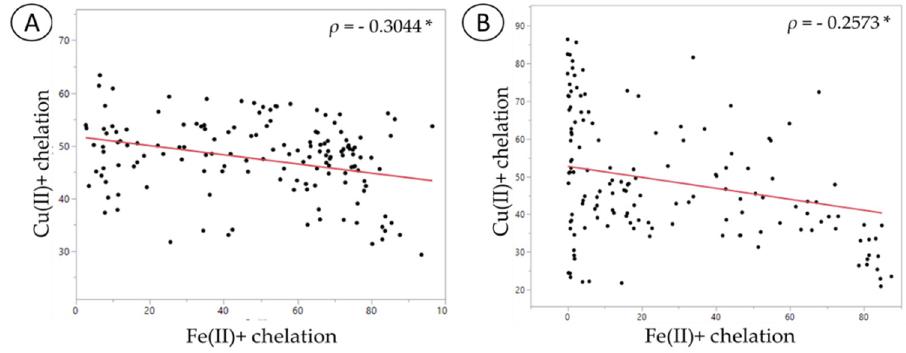
Figure 5. Spearman’s correlation analysis between copper and iron chelation assays: ( A ) Normal fecal sample; ( B ) C. difficile -infected fecal sample. The symbol * represents significant correlation ( p < 0.05).